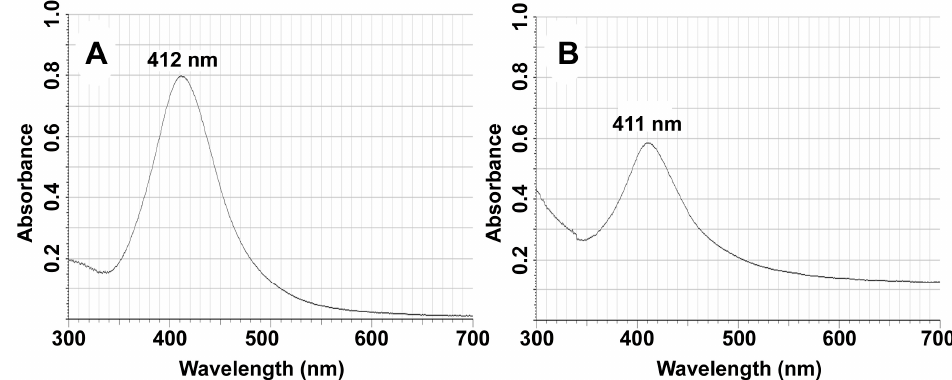
Figure 3. UV–visible absorption spectra of ( A ) Ag NPs and ( B ) SG-Ag/PAN electrospun fibers.